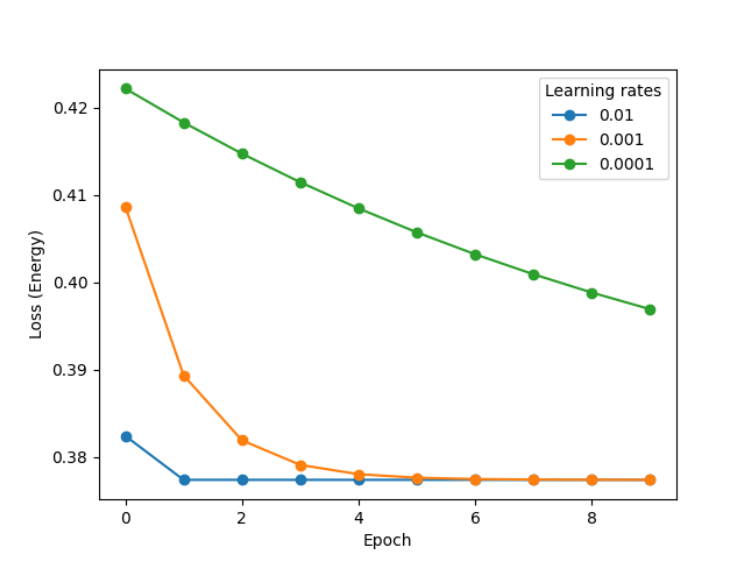
Figure 10. Gated RBM energy loss comparison with different learning rate